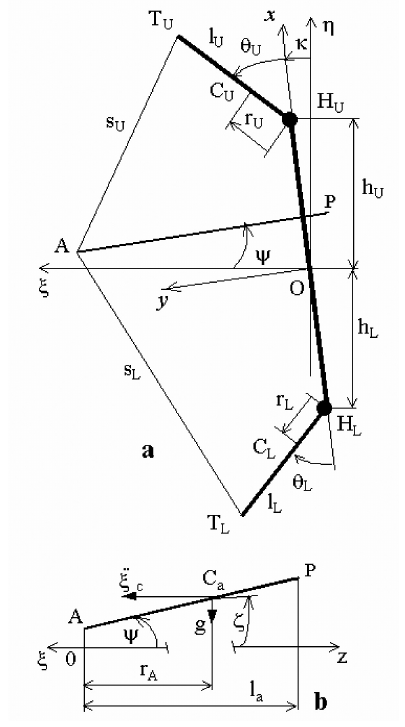
Fig. 5. (a) Dynamic schematic model of a bow; (b) schematic model of an